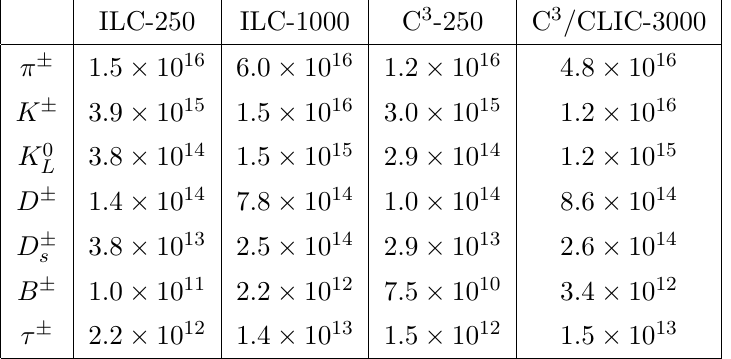
Table 2 . Total number of mesons and τ leptons produced per year at the several beam dump experiments, summing over both charged states. For pions and kaons, we show the number of mesons that decay before the first interaction length, not the total number of produced